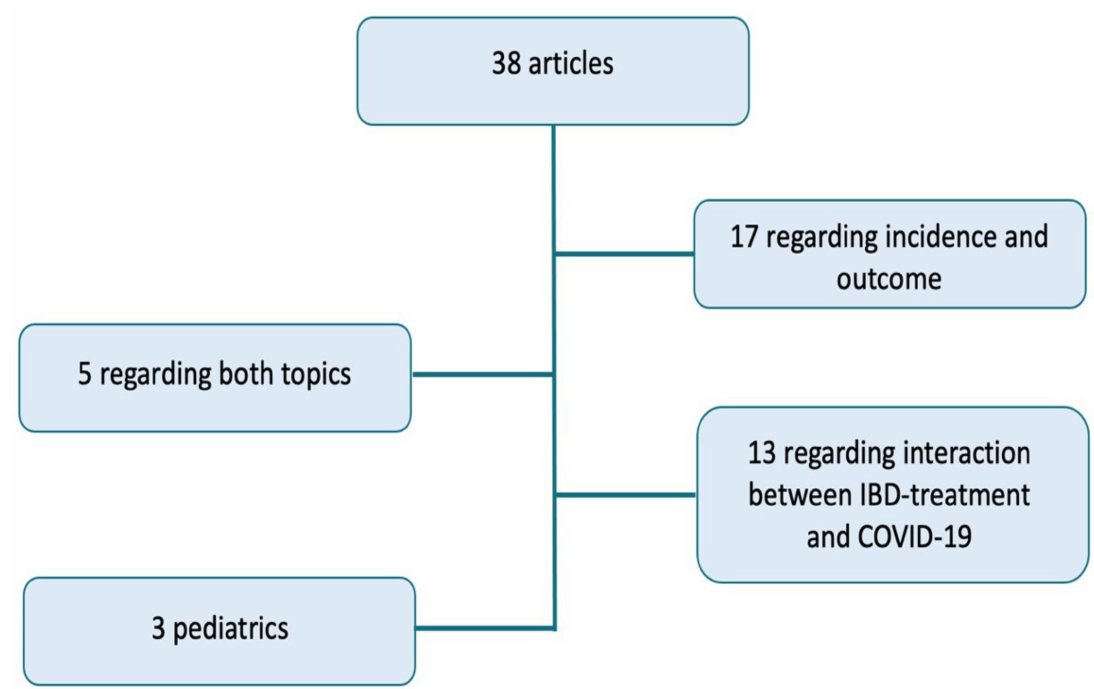
Figure 1. A summary of the 38 analyzed articles: 17 relating to the incidence and outcome of COVID-19 disease in IBD patients, 13 regarding the interaction between IBD-treatment and COVID-19, 5 regarding both these topics, and 3 exclusively children-focused